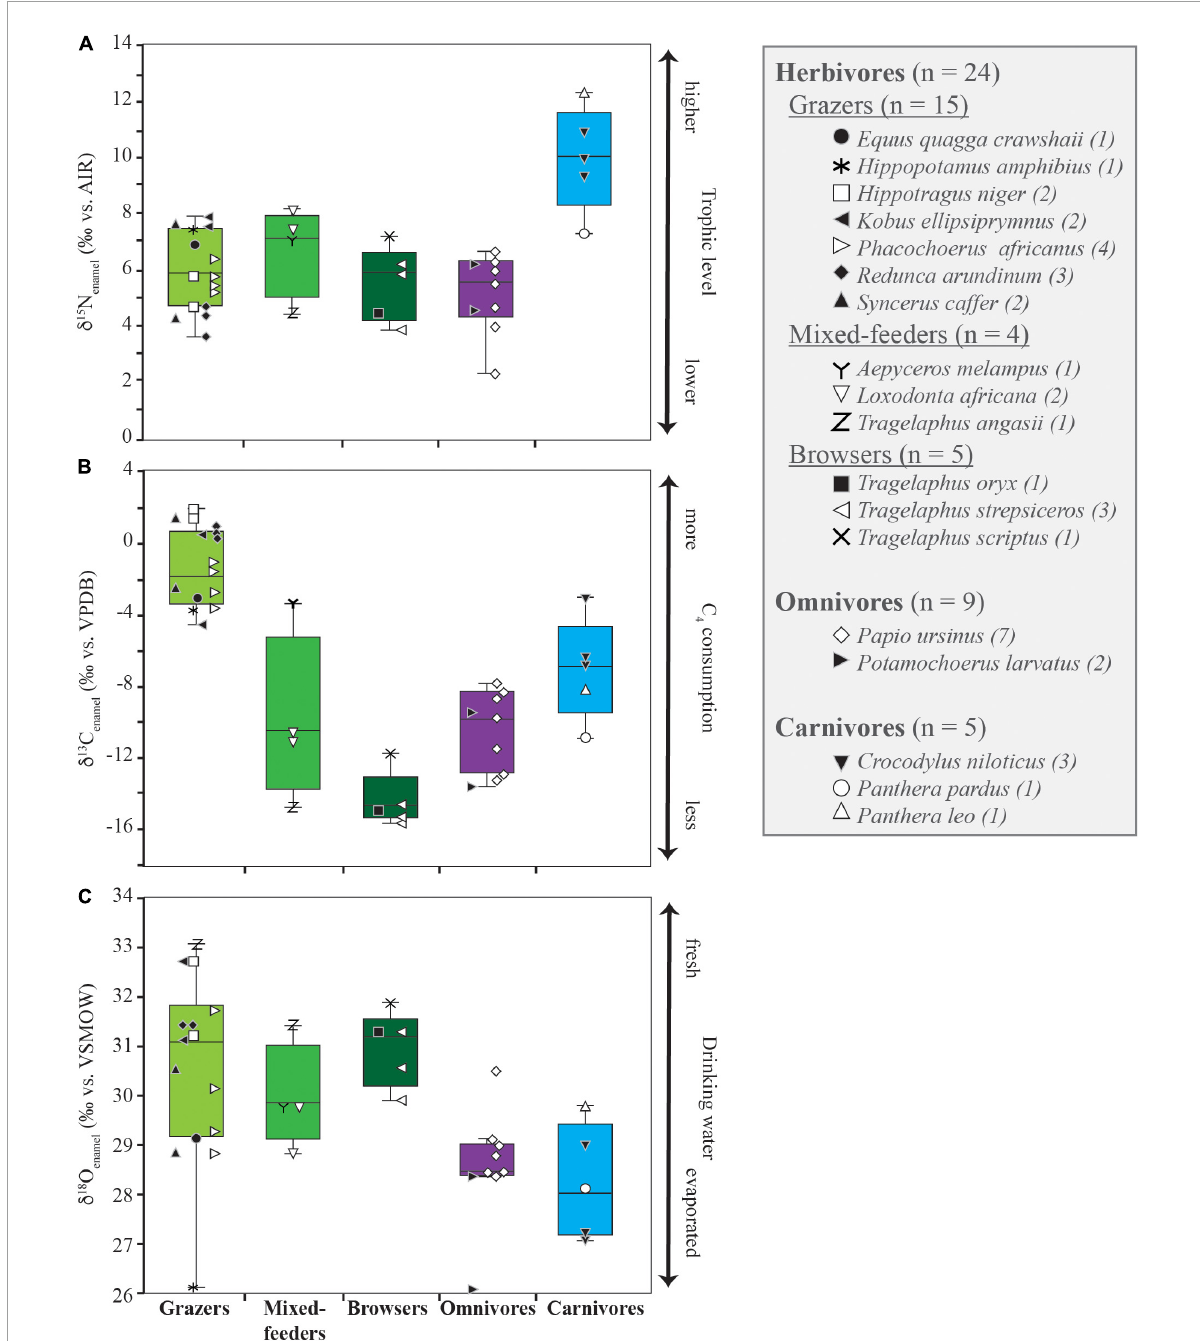
FIGURE3 δ 15 N δ 13 C δ 18 O enamel (A) , enamel (B) , and enamel (C) values for Gorongosa fauna by diet. Boxplots show the interquartile range (note outliers in omnivore δ 18 O enamel dataset), with the median indicated by the solid line. Symbols correspond to individual